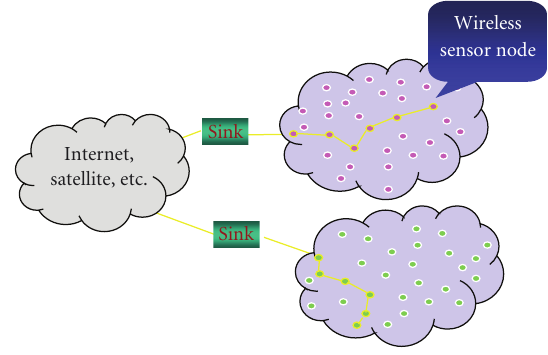
Figure 1: Wireless sensor